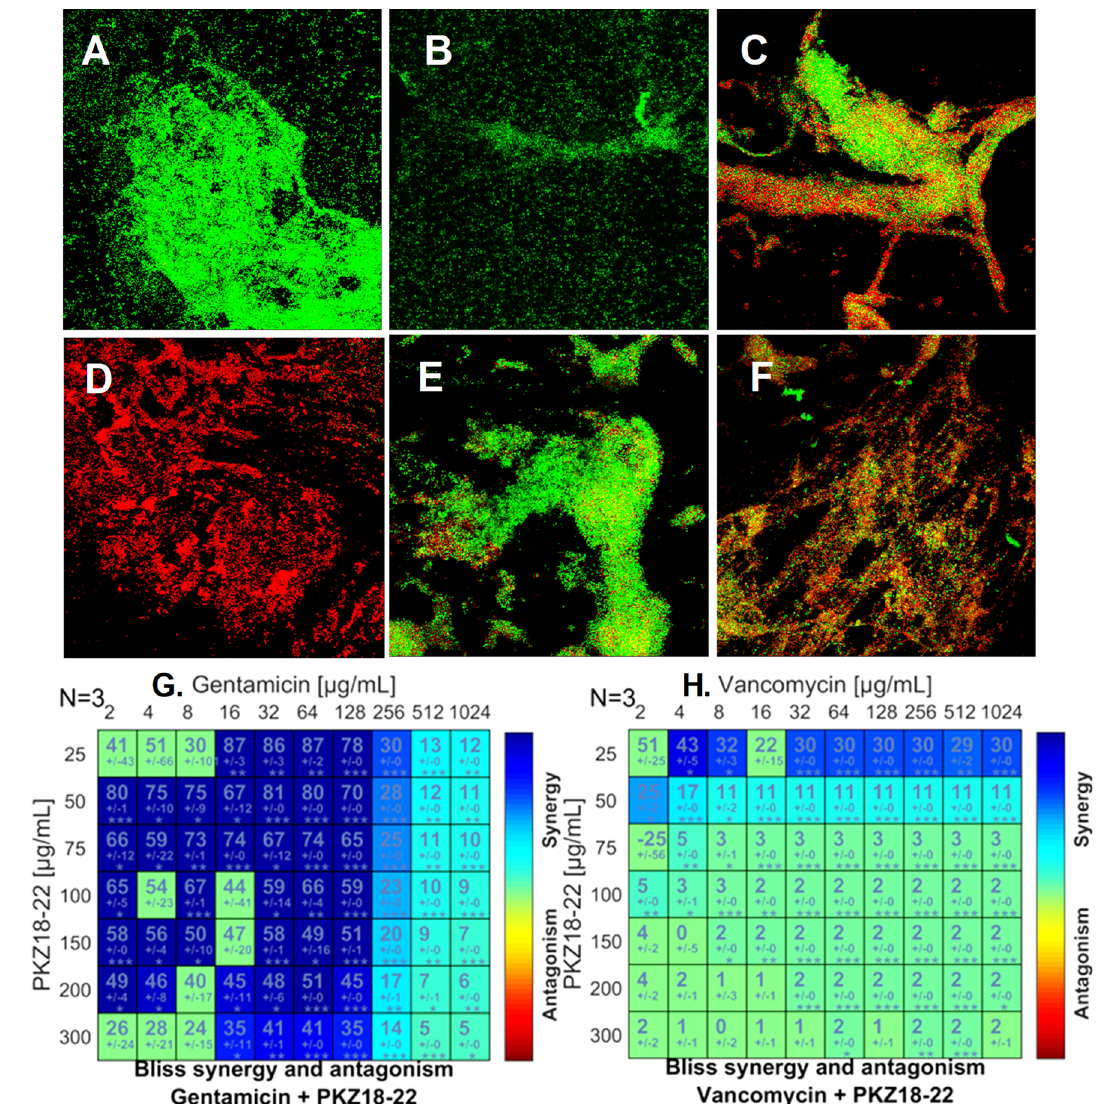
Figure 3. PKZ18-22–antibiotic synergy on S. aureus biofilm growth. ( A ) Biofilm grown for 24 h with no treatment. ( B ) Biofilm growth after 24 h exposure to 25 μ g/mL PKZ18-22. ( C ) Growth after 24 h exposure to 4 μ g/mL gentamicin. ( D ) Growth after 24 h exposure to 64 μ g/mL gentamicin + 25 μ g/mL PKZ18-22. ( E ) Growth after 24 h exposure to 4 μ g/mL vancomycin. ( F ) Growth of S. aureus after 24 h exposure to 4 μ g/mL vancomycin + 25 μ g/mL PKZ18-22. ( G ) Synergy score matrix for drug combination of PKZ18-22 and gentamicin using a drug interaction Bliss reference model. The highest drug synergy was observed with PKZ18-22 of 25 μ g/mL and gentamicin concentrations of 16–64 μ g/mL ( p < 0.001). ( H ) Synergy score matrix for drug combination of PKZ18-22 and vancomycin. By definition all synergy scores above zero are synergis- tic. Synergy scores of PKZ18-22 and vancomycin exhibited significantly lower effects compared to PKZ18-22 and gentami- cin. The highest synergy score was observed at 4 μ g/mL vancomycin + 25 μ g/mL PKZ18-22. Asterisk’s indicate level of confidence in results, probability of obtaining test results: * indicates p < 0.05; ** indicates p < 0.001; *** indicates p < 0.0001.